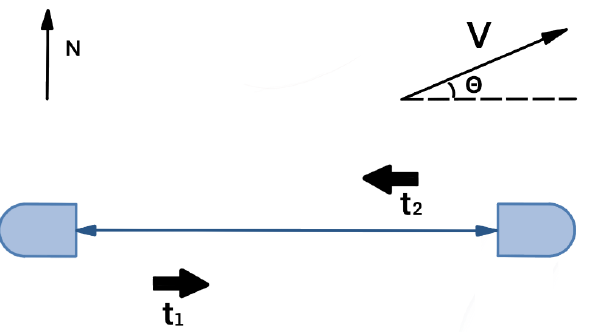
Figure 1. Unidimensional wind speed measurement based on time-difference method. As shown in Equation (1), in order to acquire a trustworthy wind speed, picking a precise arrival time is of vital importance. Previously, the automatic onset time determi- nation was carried out by a picking algorithm, which generally falls into three categories. The simplest technique is to use an amplitude threshold picker, which applies an empiri- cally determined value as a threshold to filter the received wave [11]. However, the deter- mination of this value can be puzzling and this method is not applicable in a high-noise environment. An improved method in this category is to apply a short-term-average over long-term-average (STA/LTA) filter to avoid false pick [12], but window length determi- nation remains difficult. The second type of automatic onset time picker is to apply a run- ning extraction window along the time-axis and successively calculate the characteristic function value corresponding to each picked sample. As assumed, at the time of signal arrival, the value of this characteristic function changes significantly. In this category, pre- vailing methods include Akaike information criterion (AIC) picker [13,14], Teager-Kaiser energy operator (TKEO) [15], and kurtosis-based picker [16]. The final type is to calculate the matching rate between the received wave and a reference waveform [17,18], based on the assumption of the existence of a reference waveform similar to the received wave. easily influenced by the shape of echo signal in the time domain.